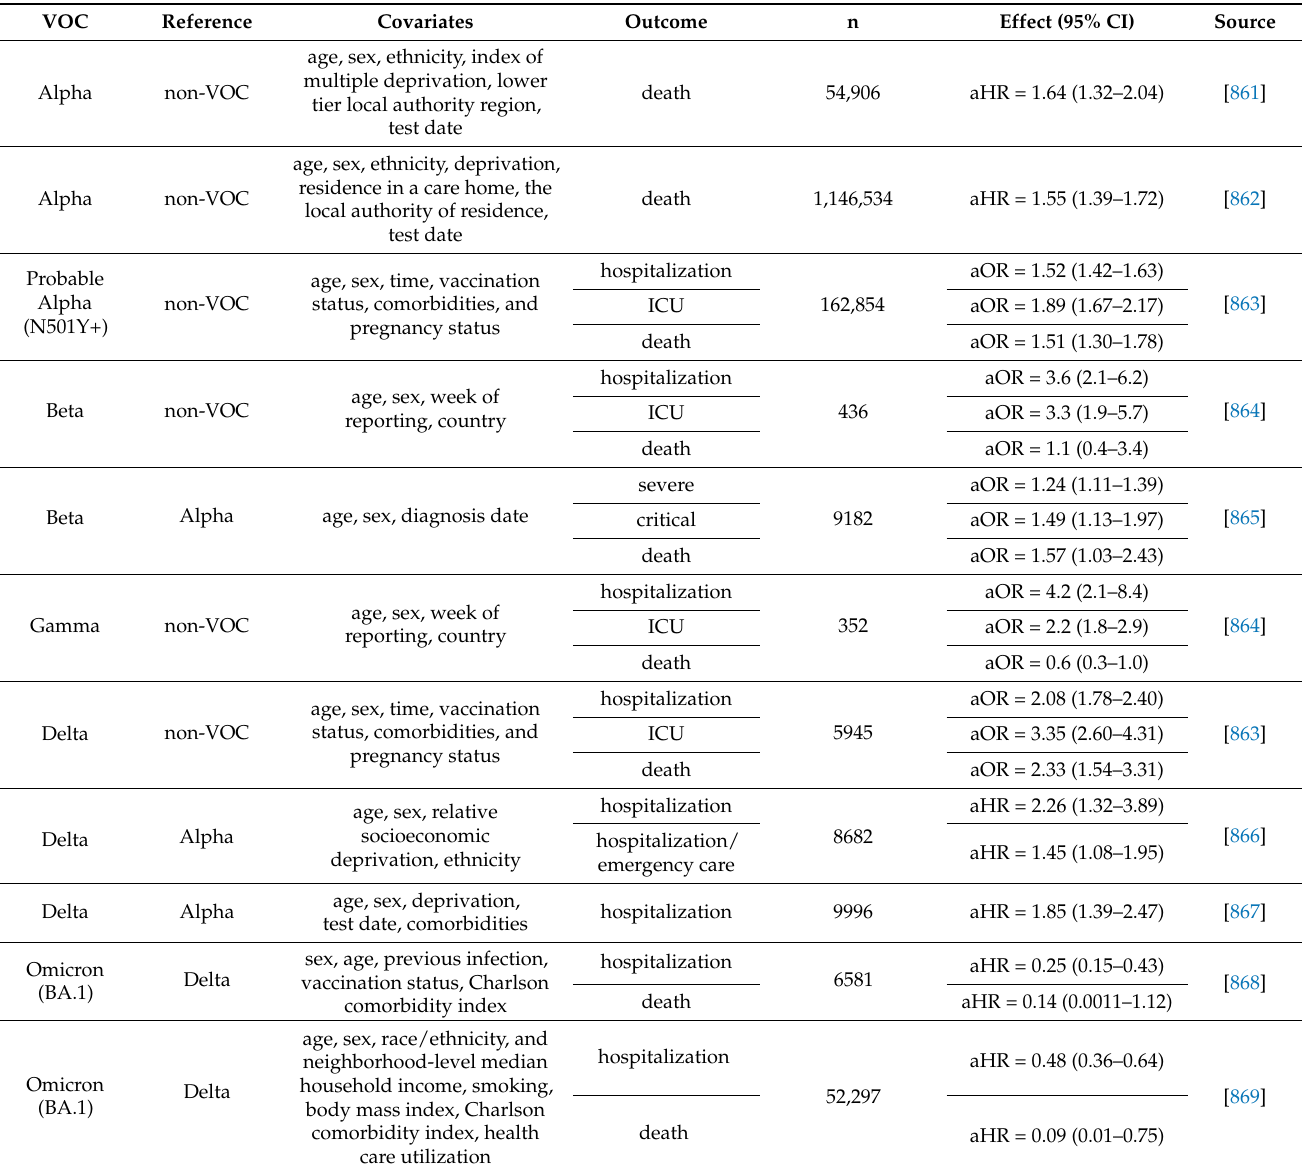
Table 6. Clinical studies investigating the impact of SARS-CoV-2 VOCs on COVID-19 disease severity compared to non-VOC or previous